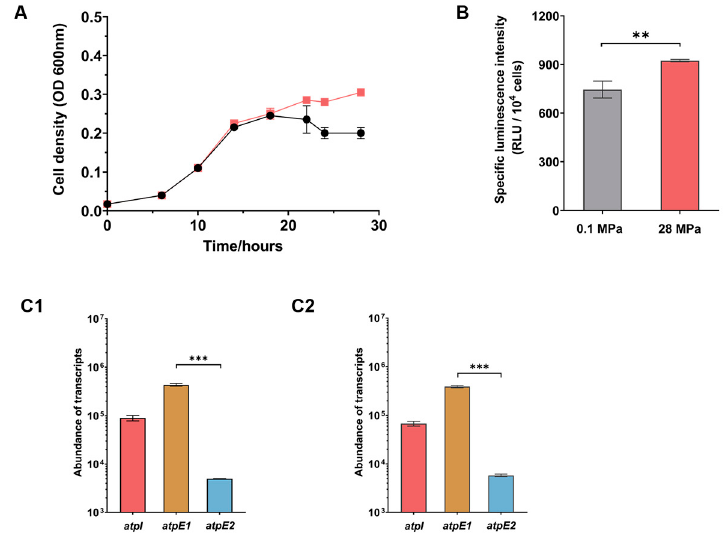
Figure 2. Growth curves, intracellular ATP level and expression levels of ATPase components in wild-type SS9R cells cultured under different pressure conditions in MB2216. Panel ( A ), growth curves of SS9R at 0.1 MPa and 28 MPa. The black lines represent growth at 0.1 MPa and the red lines represent growth at 28 MPa. Panel ( B ), intracellular ATP level in SS9R cells at exponential phase at 0.1 MPa and 28 MPa, the values show luminescence intensity per 10 4 cells. Panel ( C1 , C2 ), abundance of atpI , atpE 1 and atpE 2 transcripts at 0.1 MPa (C1) and 28 MPa (C2), respectively. The statistical analysis of comparisons between two groups was performed using an unpaired-sample t -test: **, p < 0.01; ***, p < 0.001.